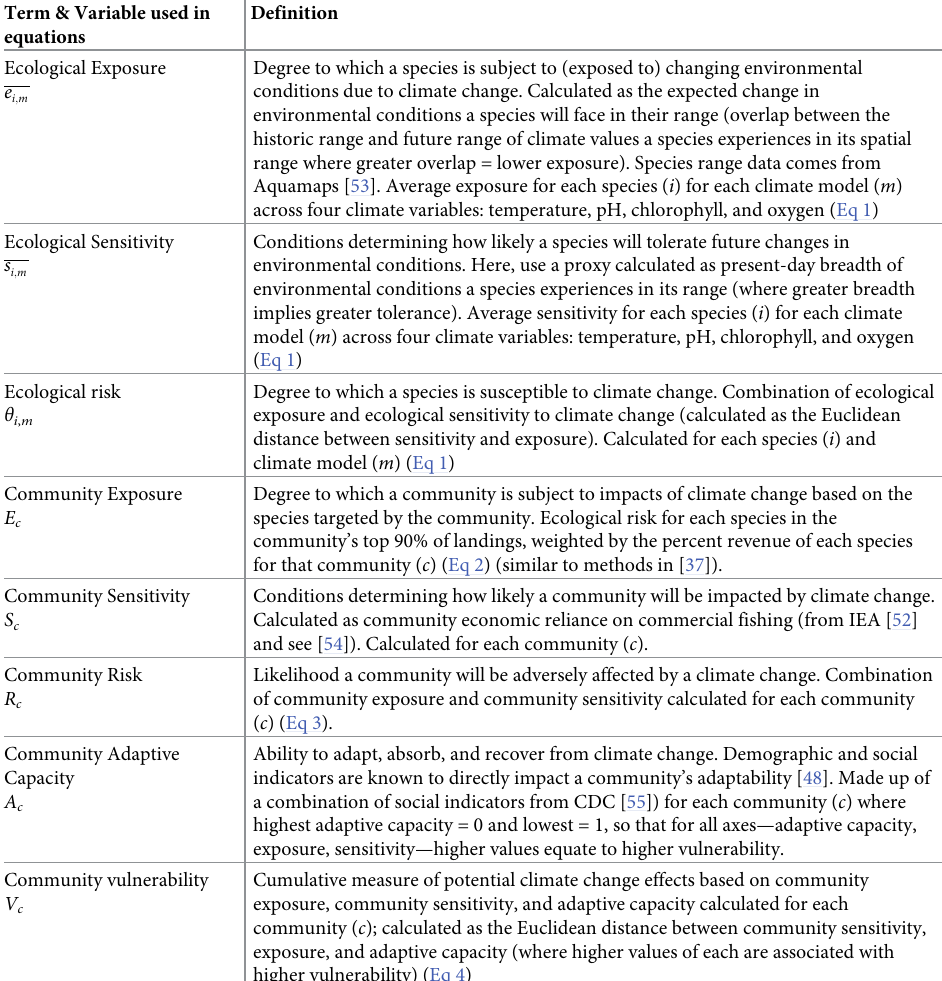
Table 1. Terms and definitions used in the vulnerability framework for coupled social-ecological